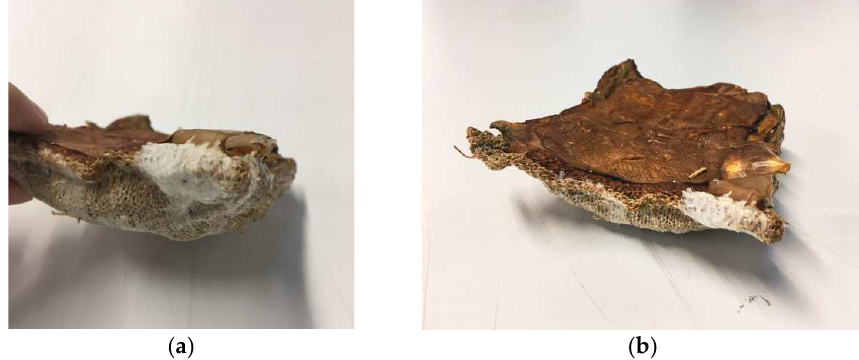
Figure 9. ( a ) Corner of the pocket with white mycelium skin. ( b ) BC dried onto the pocket, showing pattern of fabric underneath (image credit: authors).